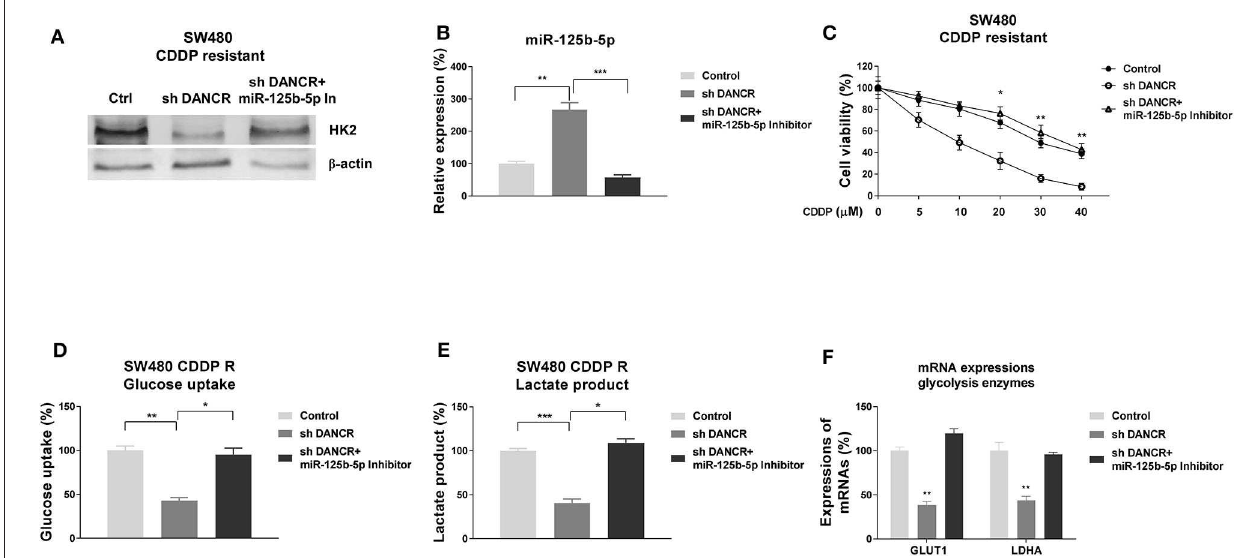
FIGURE 7 | DANCR promotes cisplatin resistance via miR-125b-5p/HK2 axis. (A) SW480/CDDP R cells were transfected with control shRNA, DANCR shRNA alone, or sh DANCR plus miR-125b-5p antisense; the expressions of HK2 and (B) miR-125b-5p were measured by Western blot or qRT-PCR, respectively. β -Actin was an internal control. (C) SW480/CDDP R cells were transfected with control shRNA, DANCR shRNA alone, or sh DANCR plus miR-125b-5p antisense; cells were treated with cisplatin at the indicated concentrations. Cell viability was measured by MTT assay. (D) SW480/CDDP R cells were transfected with control shRNA, DANCR shRNA alone, or sh DANCR plus miR-125b-5p antisense; the glucose uptake, (E) lactate product, and (F) glycolysis enzymes were measured. Data are presented as mean ± SD. * p < 0.05, ** p < 0.01, and *** p < 0.001.